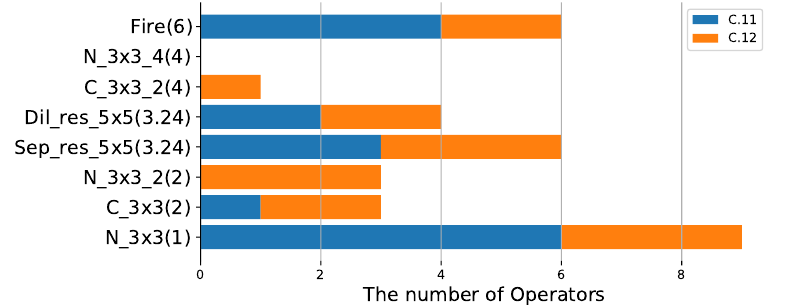
Figure 9. The distribution of operators in SOP7 when compressing resnet18 on Cifar100. C.11 and C.12 correspond to λ of 0 and 1.5 − 3 , respectively. Compared to simple operators, complex operators are more likely to be selected in compression training, indicating that complex operators are more effective, such as Fire, Sep _ res _5 × 5 and Dil _ res _5 × 5.